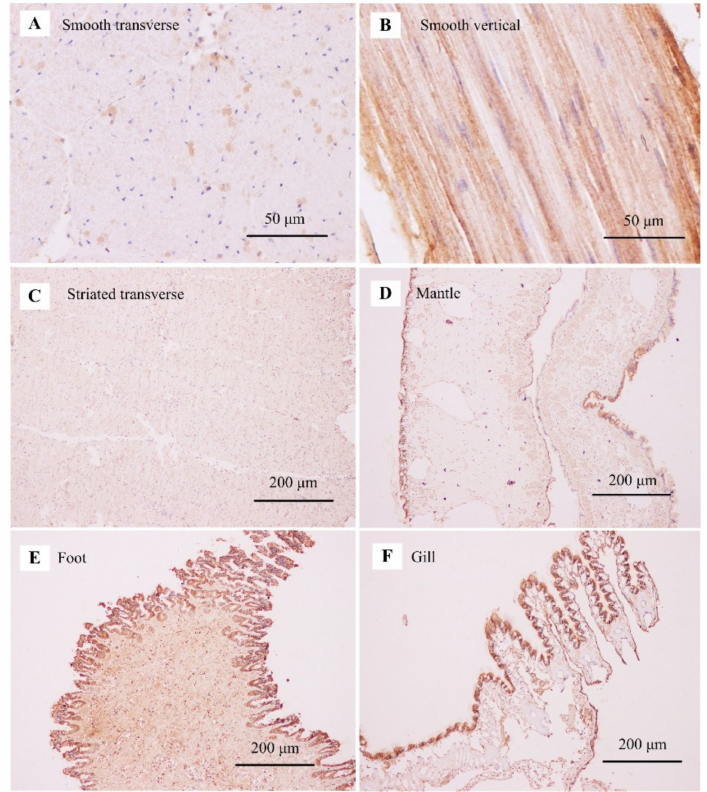
Figure 7. The immunohistochemistry staining for tissue-specific protein expression pattern of paramyosin. ( A ) Smooth adductor muscle in a transverse section; ( B ) smooth adductor muscle in a vertical section; ( C ) striated adductor muscle in a transverse section; ( D ) mantle tissue; ( E ) foot; and ( F )